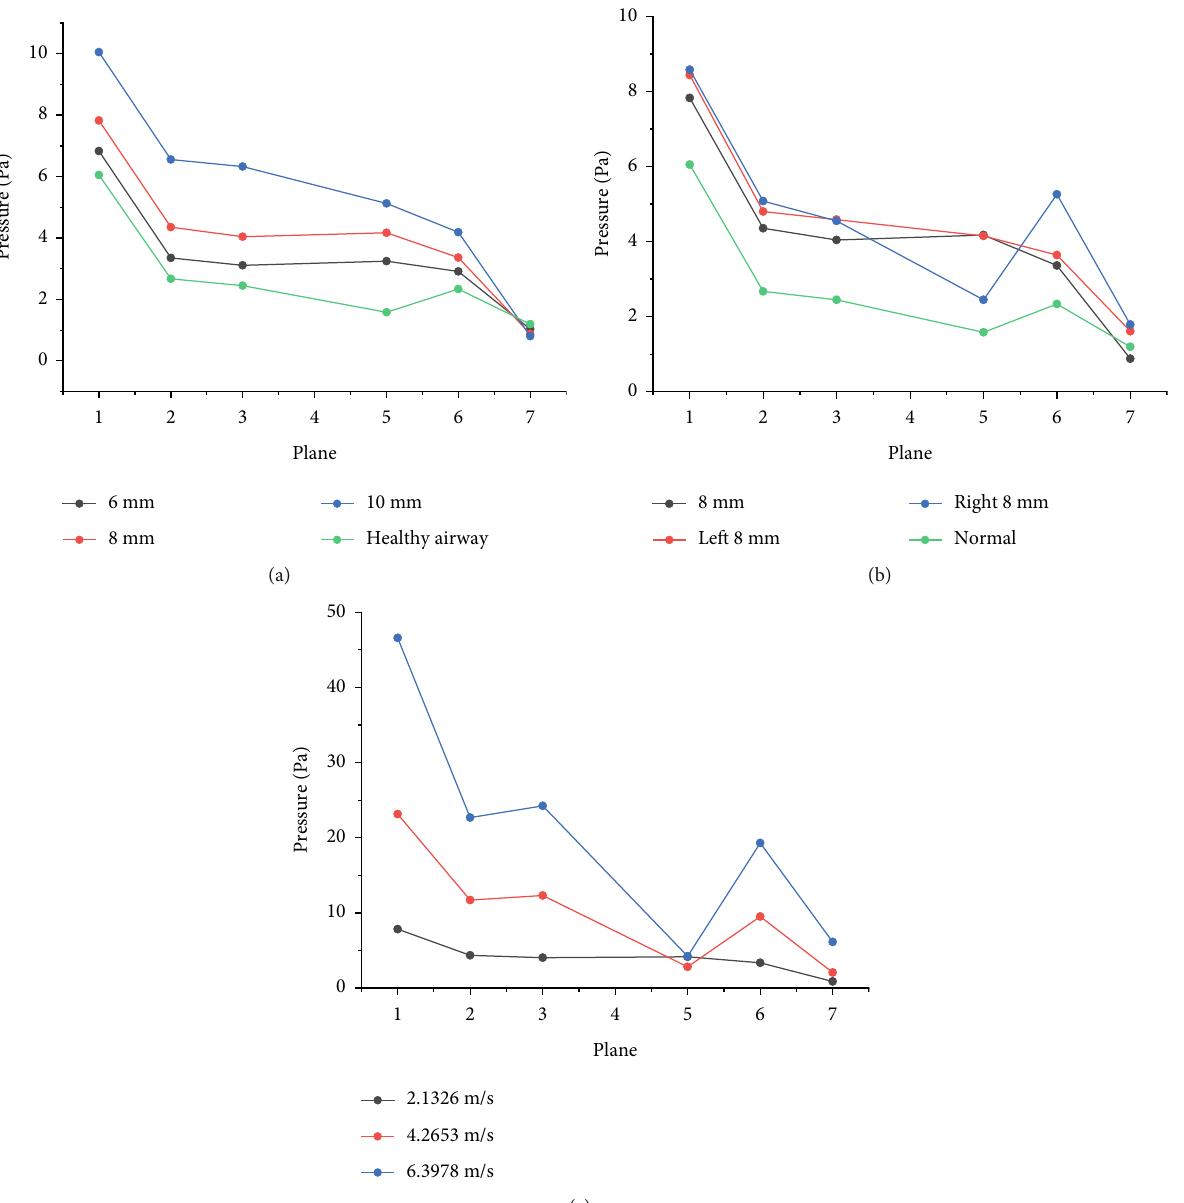
Figure 10: Pressure drops at di ff erent positions of airway at (a) di ff erent diameters, (b) di ff erent positions, and (c) di ff erent fl ow